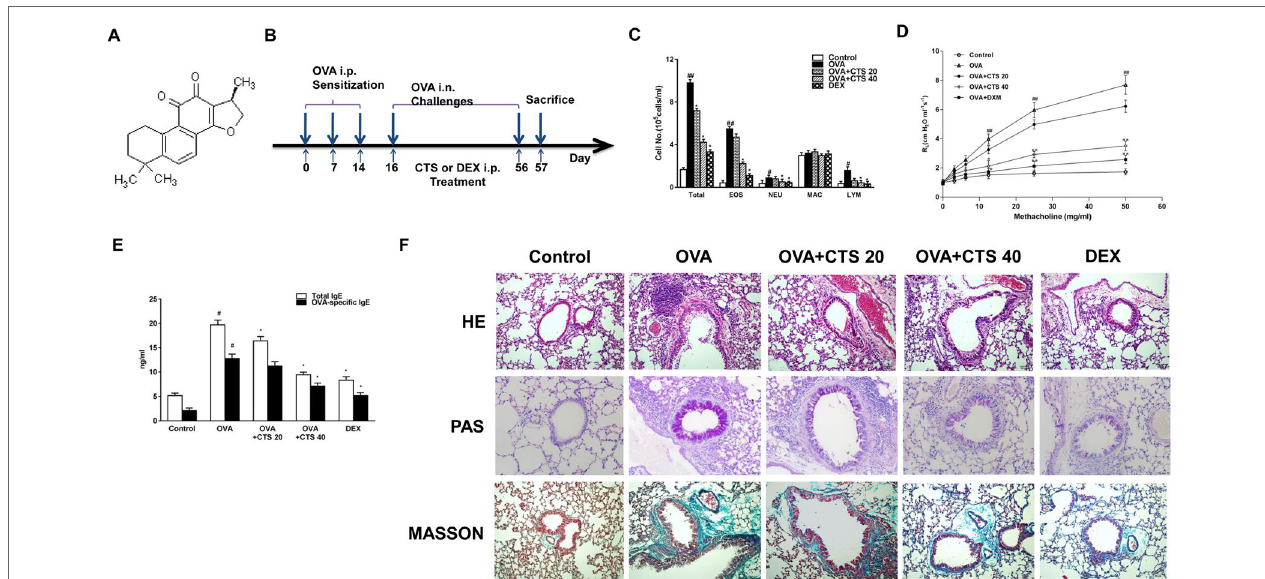
FIGURe 1 | The effect of CTS on the inflammation and airway hyperresponsiveness of the OVA-inhaled mice. (A) Chemical structure of CTS. (B) A schematic diagram of the experimental protocol. The mice were sensitized on day 0, 7, and 14 by intraperitoneal injection of 20 µg ovalbumin (OVA) emulsified in 2 mg of aluminum hydroxide gel in a total volume of 200 µl. These sensitized mice were exposed to aerosolized 5% OVA in sterile saline for three times (30 min each time) a week for 8 weeks. The mice were placed in chambers connected to an ultrasonic nebulizer to obtain a whole-body inhalation. CTS and dexamethasone (DEX) were administered through intraperitoneal injection at 30 min before nebulization. The control mice were sensitized and challenged with phosphate buffered saline (PBS) using the same protocol. (C) The numbers of total and separate cellular components of bronchoalveolar lavage fluids (BALFs) were counted. EOS,